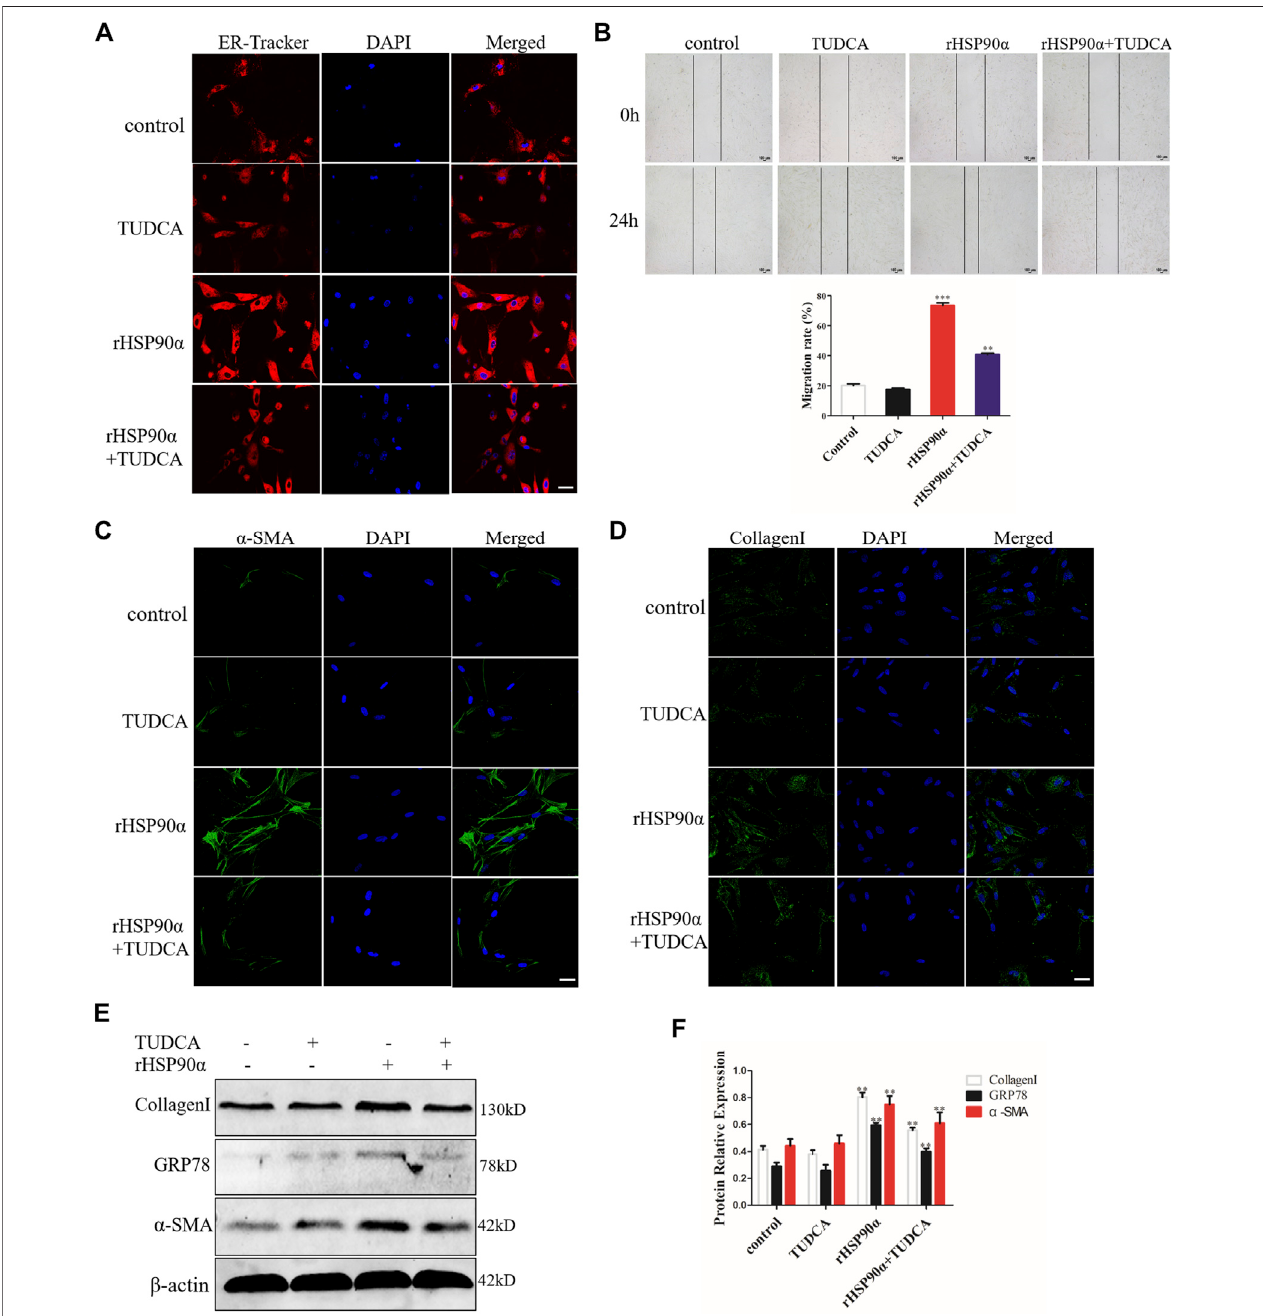
FIGURE4| ExtracellularHSP90 α activates lung fi broblasts via ERStress. (A) . Representativeimages showing ER-TrackerstainingofIMR90 cellspre-treated with or without TUDCA (100 μ M) and followed by rHSP90 α for 24 h, scale bar (cid:1) 50 μ m. (B) . Cell migration was examined in IMR90 cells by a wound healing assay. (C,D) . Representativeimagesshowingimmuno fl uorescencestainingof α -SMAandCollagenIinIMR90cells. (E,F) .WesternblotanalysisoftheexpressionofCollagenI,GRP78 and α -SMA. β -actin was used as an internal control. * p < 0.05, ** p < 0.01.